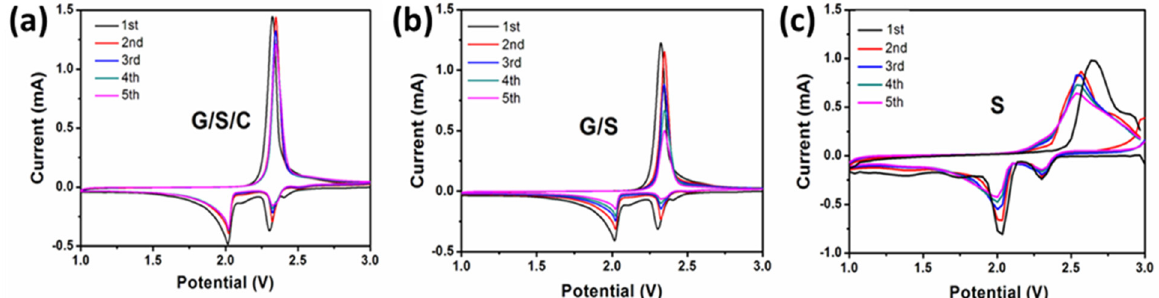
Figure 6. CV curves in the initial 5 cycles of Li-S cells using ( a ) G/S/C; ( b ) G/S; and ( c ) pure S as the cathode materials at 0.1 mV·s − 1 in the potential window from 1 V to 3 V ( vs. Li/Li + ). 1 mol·L − 1 lithium bis-trifluoromethanesulfonylimide + 0.1 mol·L − 1 LiNO 3